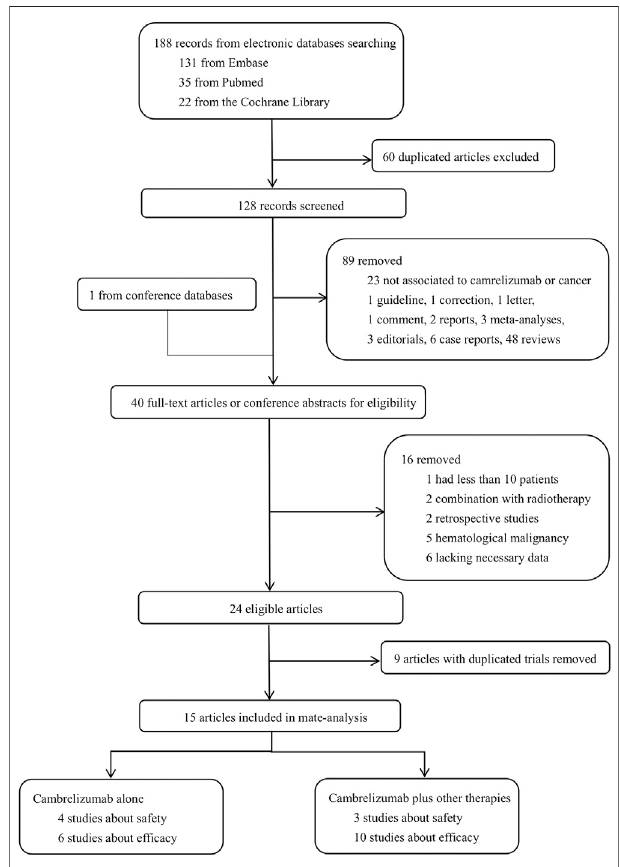
FIGURE 1 | Progress of article